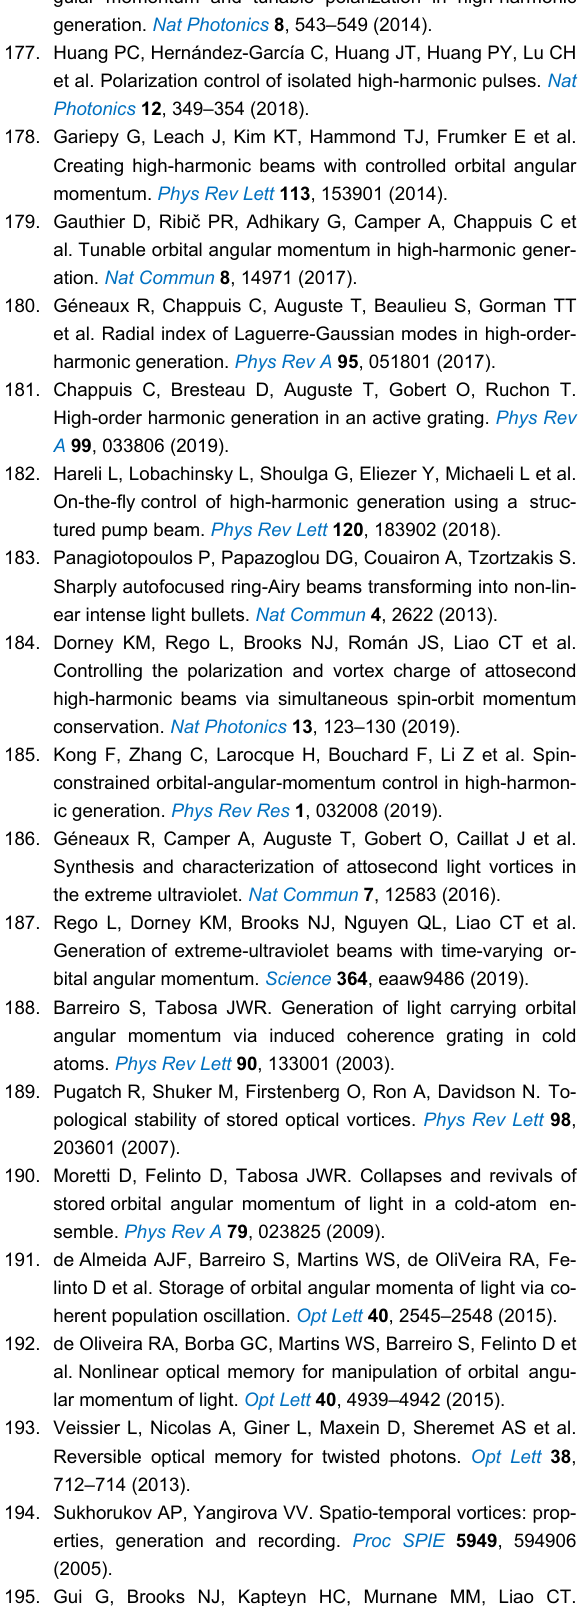
Tabosa JWR, Petrov DV. Optical pumping of orbital